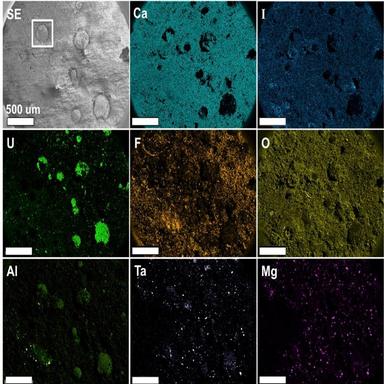
Large area elemental X-ray maps of the slag-like material on the metal product's surface. All scale bars are 500 μm. The white square in the SE image indicates the region magnified in